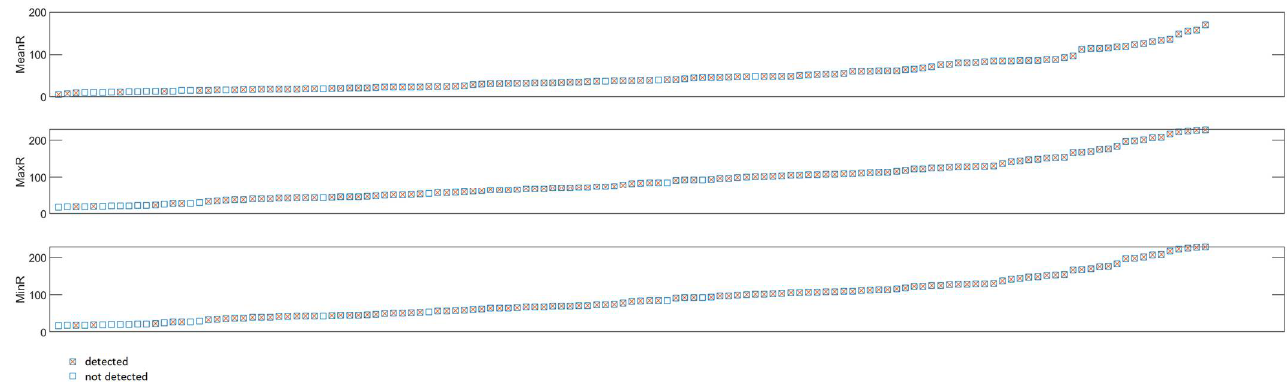
Figure 11. Analysis of the F-points’ detection ability, depending on the spectral response for red.